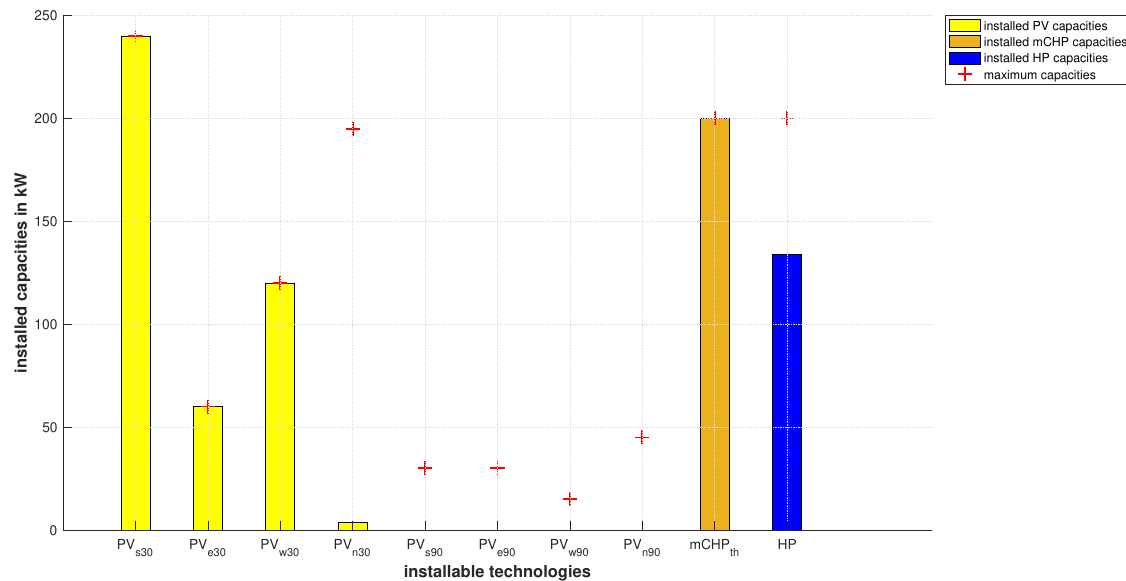
Figure 4. Installed local energy capacities for the housing associations’ business case ‘Full Contracting’.